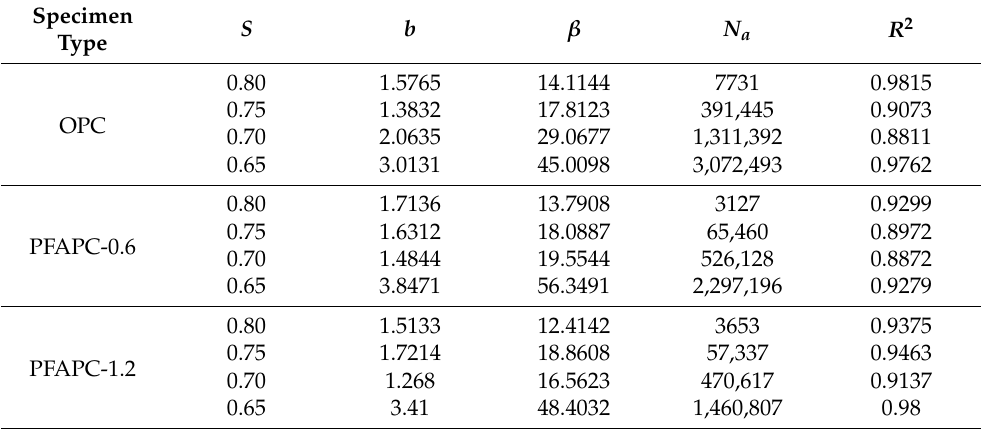
Table 6. Linear regression analysis results.